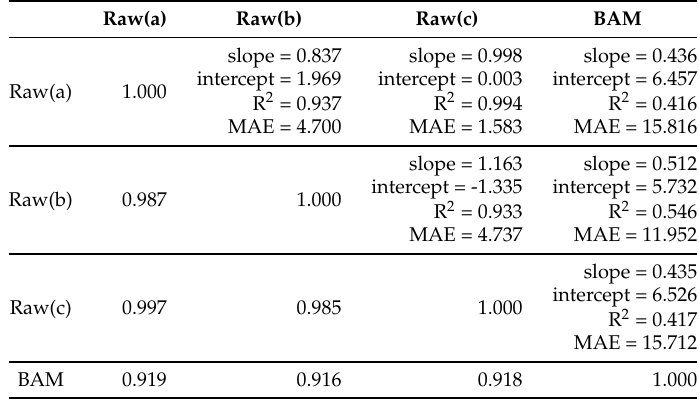
Table A1. Correlation coefficient and metrics of low-cost sensor and governmental BAM (before calibration).